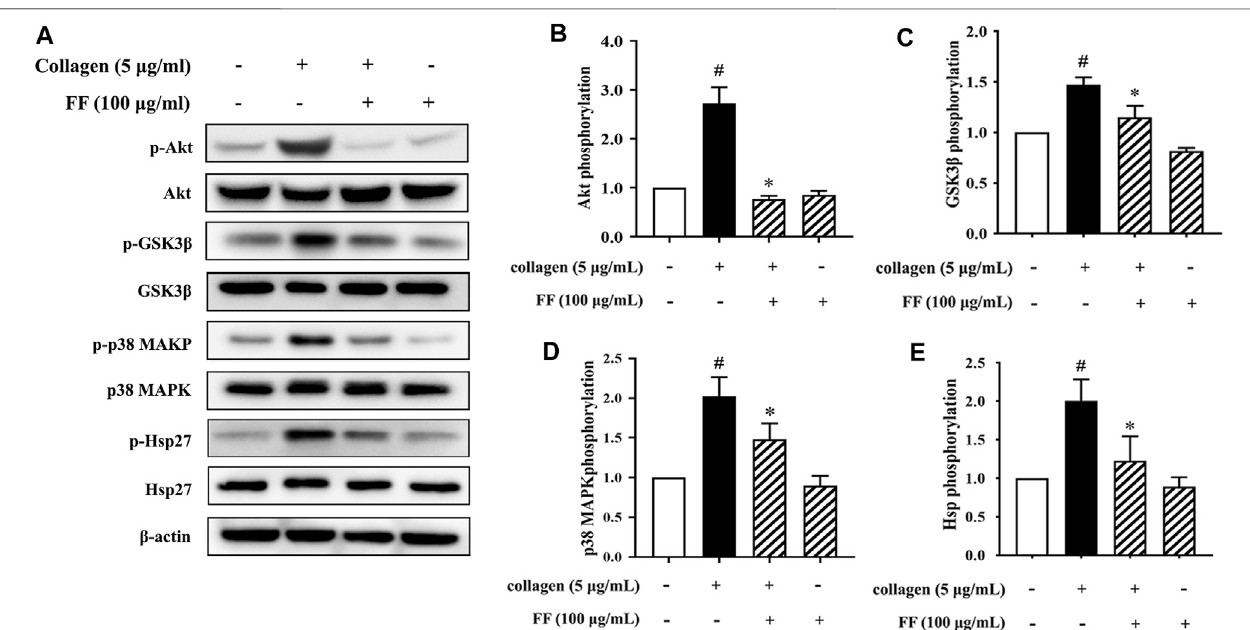
FIGURE 4 | Validation of effect of FF on Akt, GSK3 β , p38 MAPK, and Hsp phosphorylation in collagen-stimulated platelets. (A) Fruit fl ow suppressed Akt, GSK3 β , p38 MAPK, and Hsp phosphorylation in collagen-stimulated platelets. (B) Density analysis of Akt phosphorylation in FF-treated collagen-stimulated platelets and collagen-stimulated platelets alone. (C) Density analysis of GSK3 β phosphorylation in FF-treated collagen-stimulated platelets and collagen-stimulated platelets alone. (D) Density analysis of p38 MAPK phosphorylation in FF-treated collagen-stimulated platelets and collagen-stimulated platelets alone. (E) Density analysis of Hsp phosphorylation in FF-treated collagen-stimulated platelets and collagen-stimulated platelets alone. The data represent three independent experiments. * p < 0.05, signi fi cant difference between FF-treated collagen-stimulated platelets and collagen-stimulated platelets alone. # p < 0.05, signi fi cant difference between collagen- treated platelets and